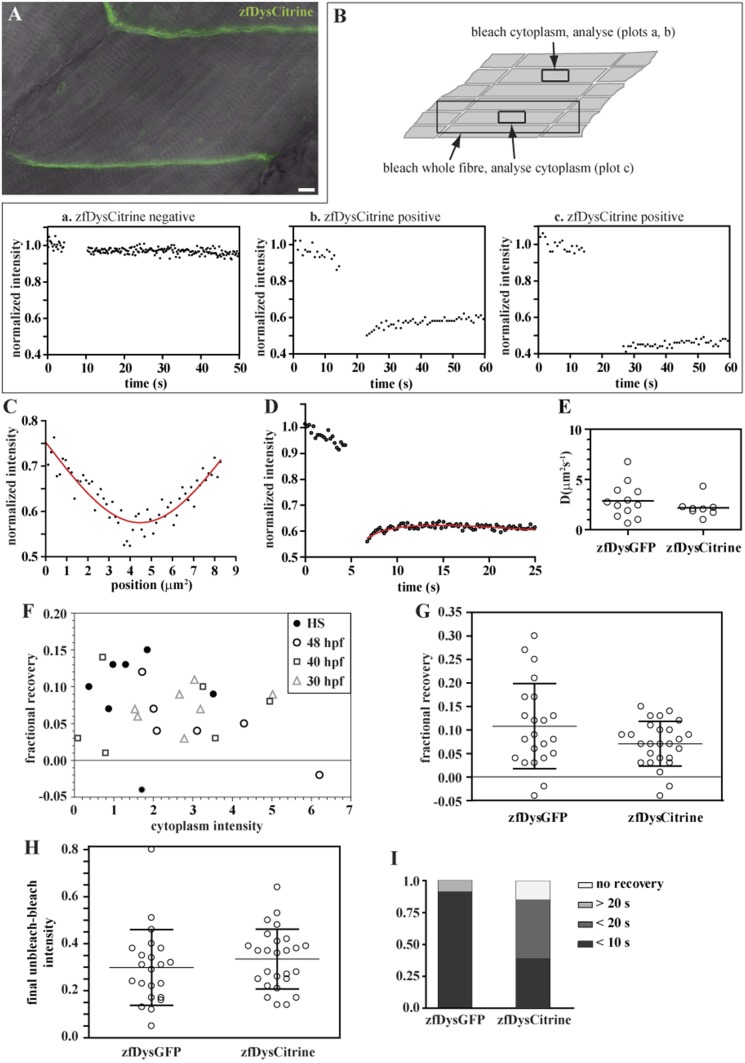
Endogenously driven zfDysCitrine dynamics.(A) In vivo zfDysCitrine (green) expression in muscle fibres of 2 dpf Gt(dmd-citrine)ct90a embryo contrasted with transmitted light. (B) Schematics of zebrafish muscle fibres showing origin of scatter plots a, b, and c. Bleaching a region in the cytoplasm of Citrine-negative siblings (a) results in a flat curve of background fluorescence intensity, while the same experiment in Citrine-positive embryos (b) results in a significant drop in fluorescence followed by recovery. Bleaching a large region to include the entire fibre abolishes recovery (c), indicating that recovery from a citrine dark state makes a negligible contribution to recovery in (b). (C, D) Normalized FRAP experimental data and fitting curves of a zfDysCitrine fibre cytoplasm. (C) Normalized intensity profile along the X-axis at the first time point after bleaching (dots) and Gaussian fit (red line). (D) Recovery curves along X-axis (dots) and fit of the diffusion model to the post-bleach (red line). (E) Comparative scatter plots of DzfDysGFP and DzfDysCitrine. t test shows no statistically significant differences. (F) Scatter plot of fractional recovery in bleached tip pixels as a function of the cytoplasmic intensity, for zfDysCitrine embryos of different developmental stages. HS = heat-shocked embryos. (G) Comparative scatter plots, with mean and SD, of the fractional recovery in bleached tip pixels of zfDysGFP and zfDysCitrine. t test shows no statistically significant difference. (H) Comparative scatter plots, with mean and SD, of final unbleached tip minus bleached tip intensities of zfDysGFP and zfDysCitrine. t test shows no statistically significant differences. (I) Fraction of cases showing no recovery, or 50% recovery at the first (<10 s), second (<20 s), or later (>20 s) time points, calculated from unbleached tip minus bleached tip intensities, in zfDysGFP and zfDysCitrine. t test shows a statistically significant difference (p = 0.0016). Scale bar = 10 µm.